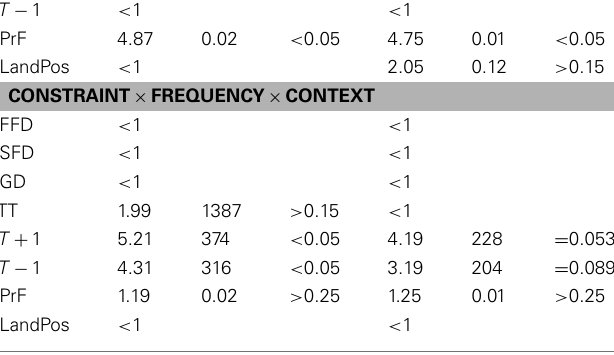
FFD, first fixation duration; SFD, single fixation duration; GD, gaze duration; TT, total fixation time;T + 1, next forward-going fixation from target; PrF, probability of target fixation; LandPos, landing position on